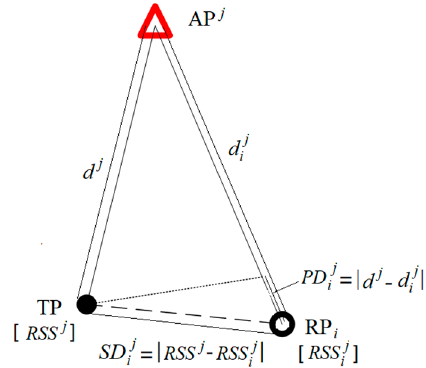
Figure 2. Sketch of physical distance and spatial distance.